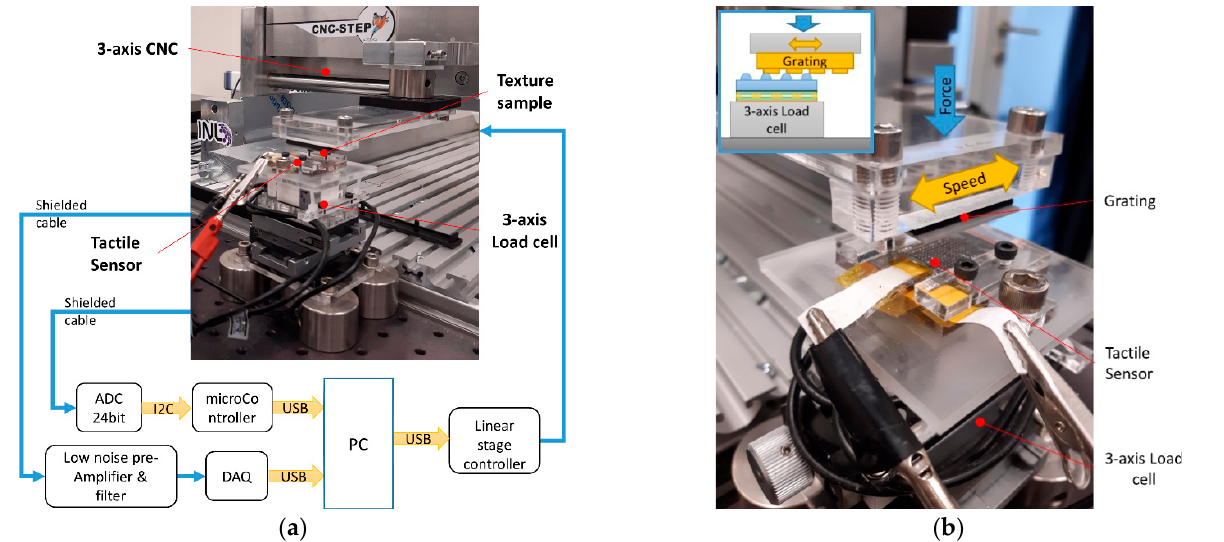
Figure 4. Experimental setup: ( a ) picture and block diagram of the experimental setup with data acquisition equipment and ( b ) tactile sensor fixed on top of the load cell.